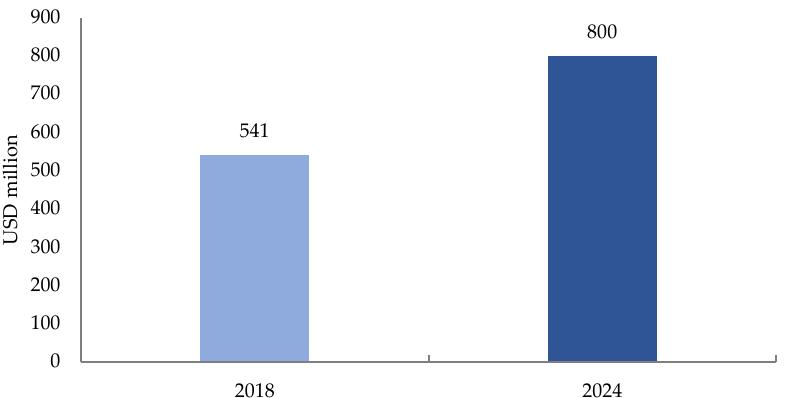
Figure 9. The global market value of MSW gasification in 2018 and forecast to 2024 (adapted from [108]).